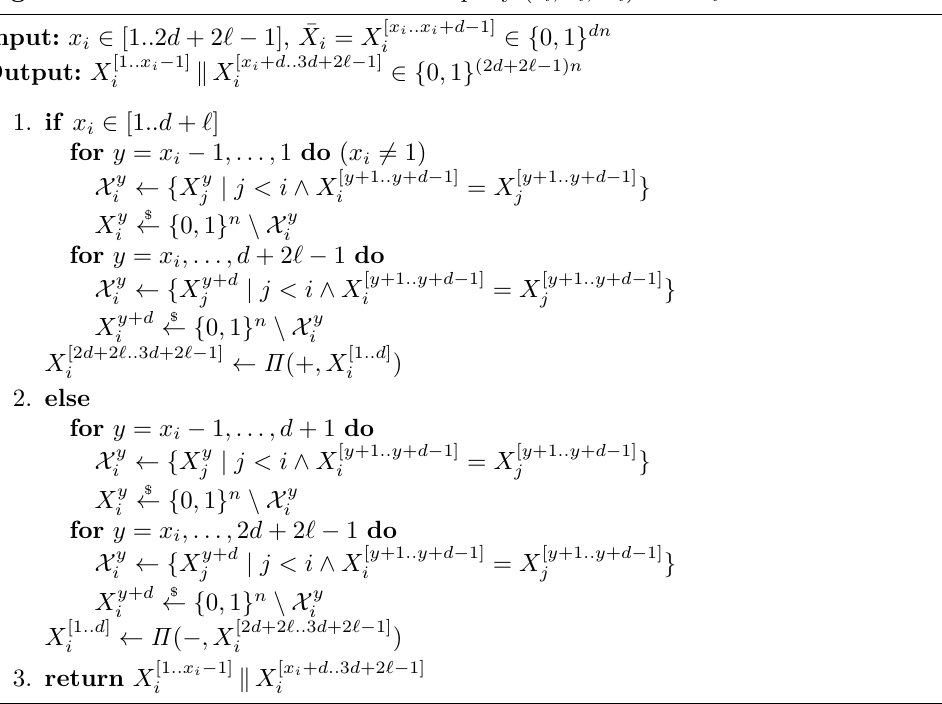
¯ X i , x i , i ) with δ i = −